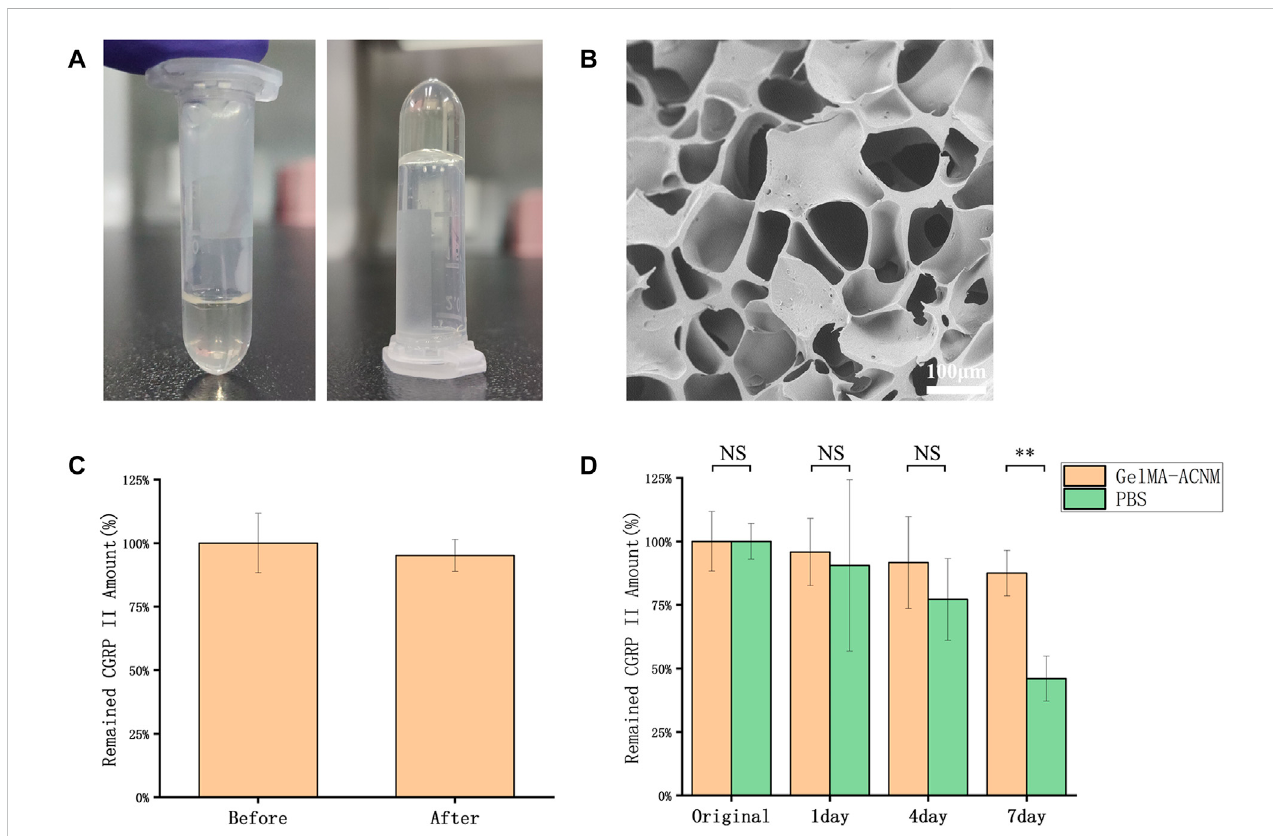
FIGURE 2 ACNM-GelMA characterization. (A) Optical images of the ACNM-GelMA. (B) SEM image of ACNM-GelMA. (C) The effective amounts of intact CGRP II before and after UV irradiation, determined with EIA. (D) The stability of CGRP II peptides retained in the GelMA-ACNM hydrogel, determined with EIA. The data are expressed as the means ± SD ( n = 3). * p < 0.05, ** p <